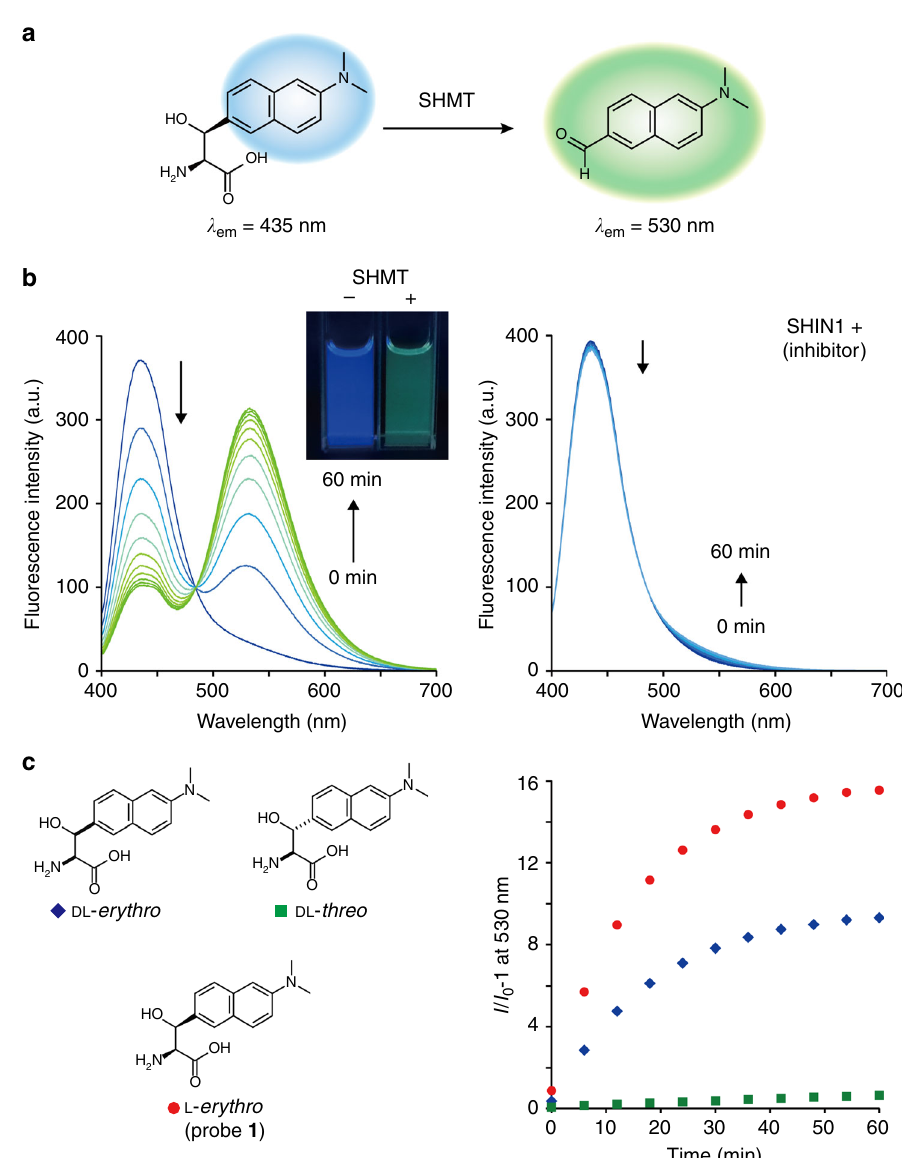
Fig. 4 Fluorescent probe targeting hSHMT. a Schematic illustration of hSHMT fl uorescent probe 1 . b Fluorescence spectral change of probe 1 (4.6 μ M) during the hSHMT1-catalyzed reaction from 0 to 60min. Excitation at 390 nm. Assay conditions: 5 units/mL hSHMT1, 50mM HEPES buffer (pH 7.5), 100 mM NaCl, 0.5 mM EDTA, 1mM dithiothreitol (DTT), with or without inhibitor (±)-SHIN1 10 µ M, 0.6% DMSO, 37°C. The inset shows the fl uorescence change of probe 1 (5 μ M). c Conversion rate analysis of DL - erythro , DL - threo , or L - erythro probes (4.6 µ M) by time-dependent fl uorescence analysis at 530nm (excitation at 390 nm). I 0 at 530nm is the fl uorescence intensity under the condition without hSHMT1. Source data are provided as a Source Data fi